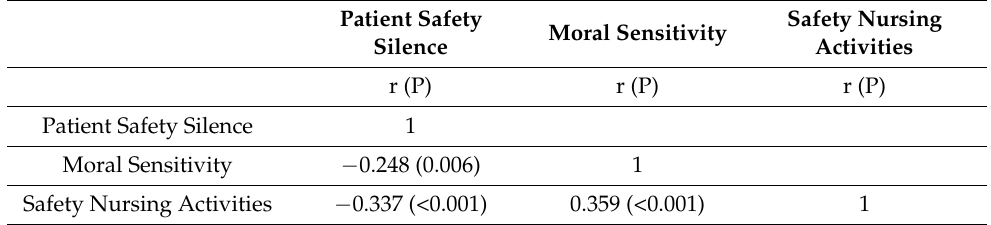
Table 3. Correlation of patient safety silence, moral sensitivity, and safety nursing activities (n =